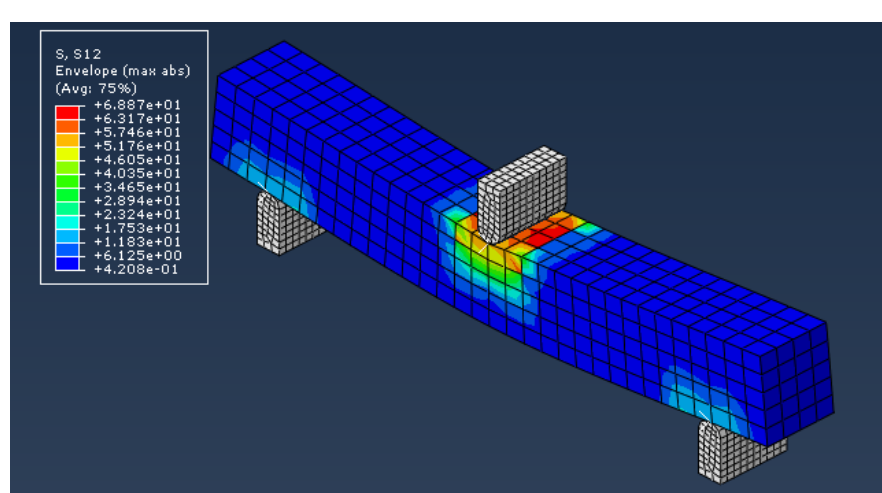
Figure 10. Three-point shear analysis of the specimen.